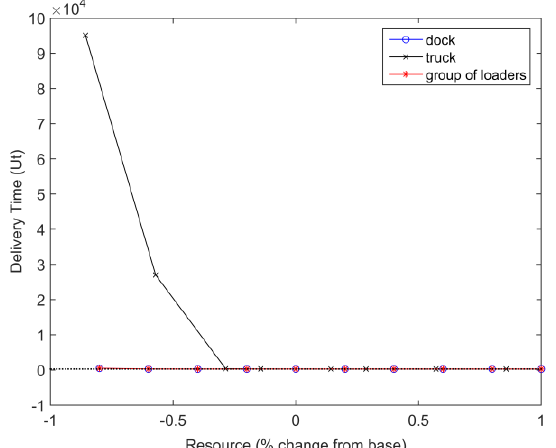
Fig. 4. Changes in multiple parameters (resources) for a single output variable (time delivery).